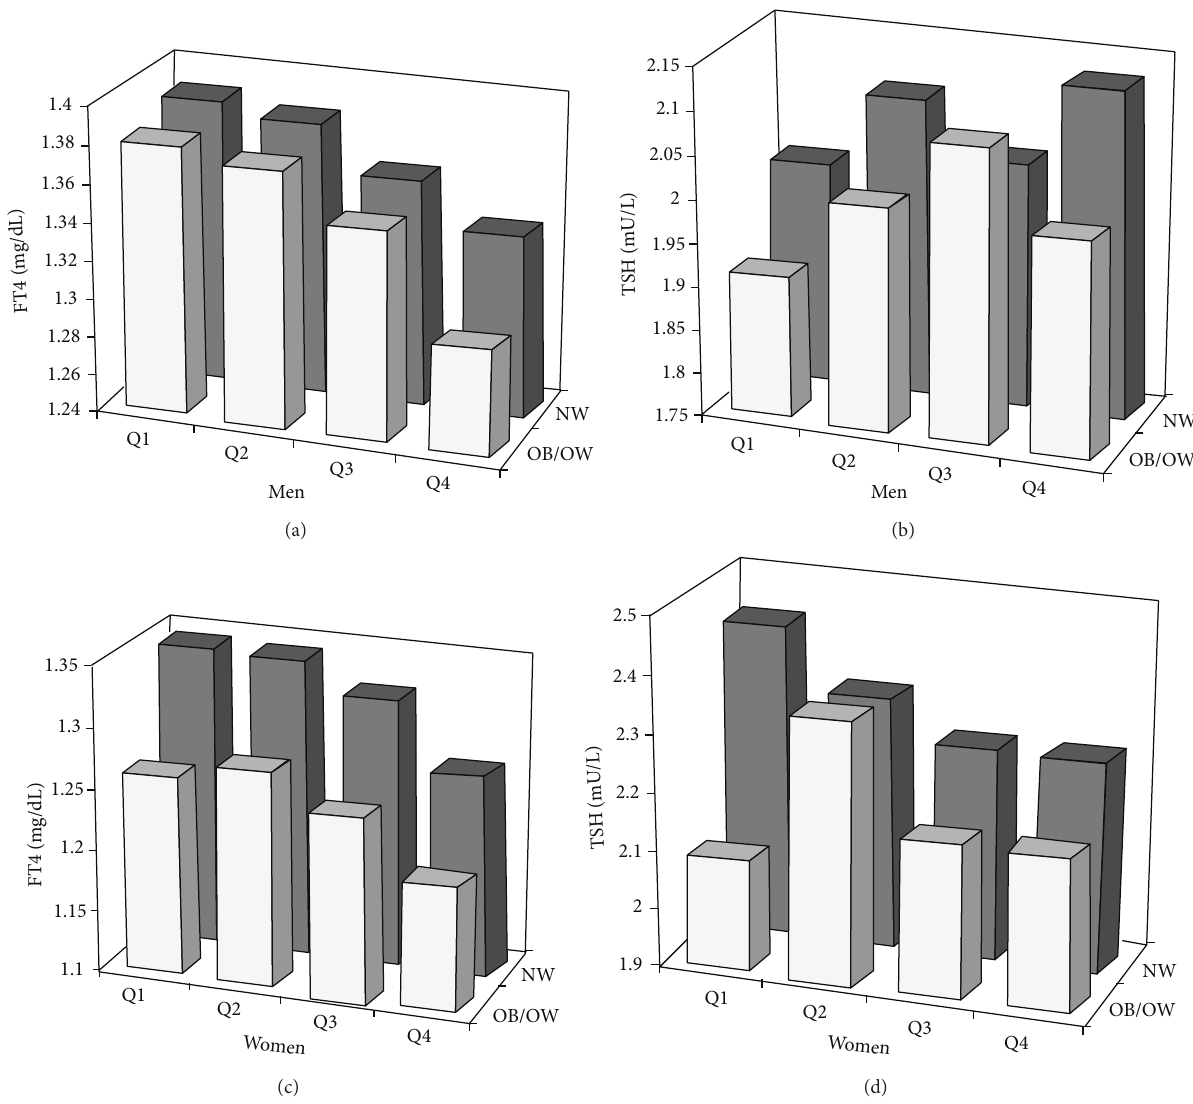
Figure 1: Age-adjusted relationship between HOMA-IR quartiles, obesity categories, and FT4 or TSH in men (a, b) and women (c,